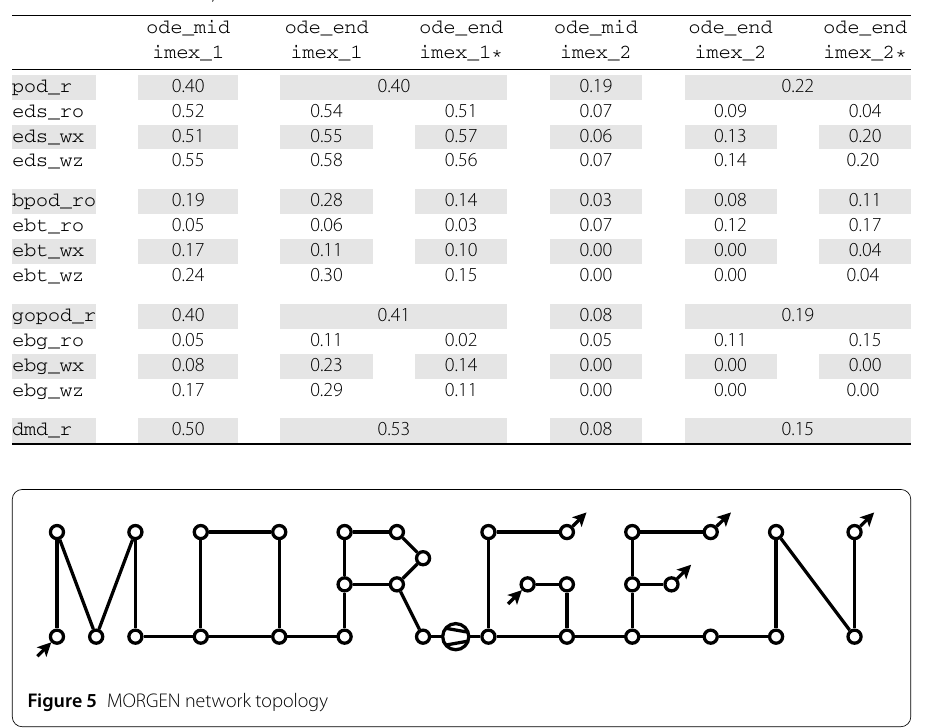
Figure 5 MORGEN network